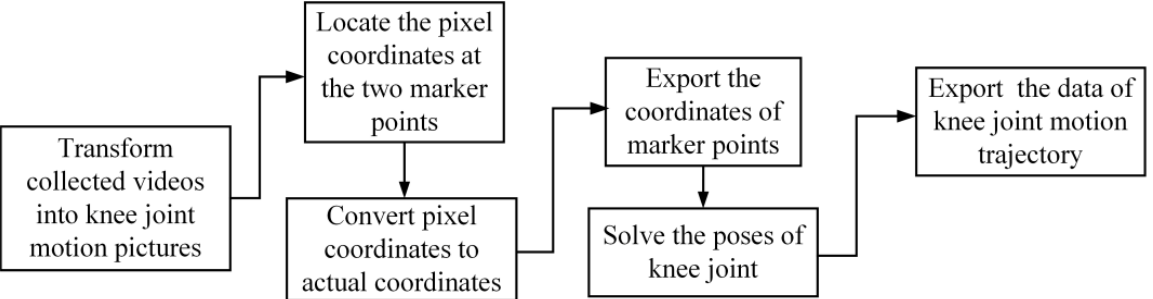
Figure 7. Video processing flow.